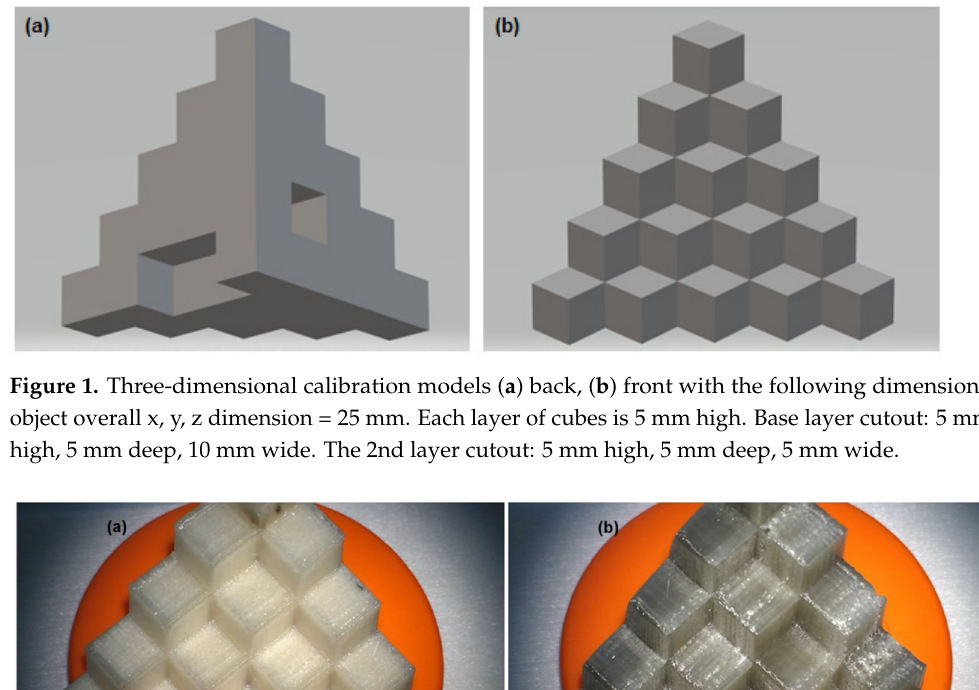
Table 1. Composition of the tested filaments.